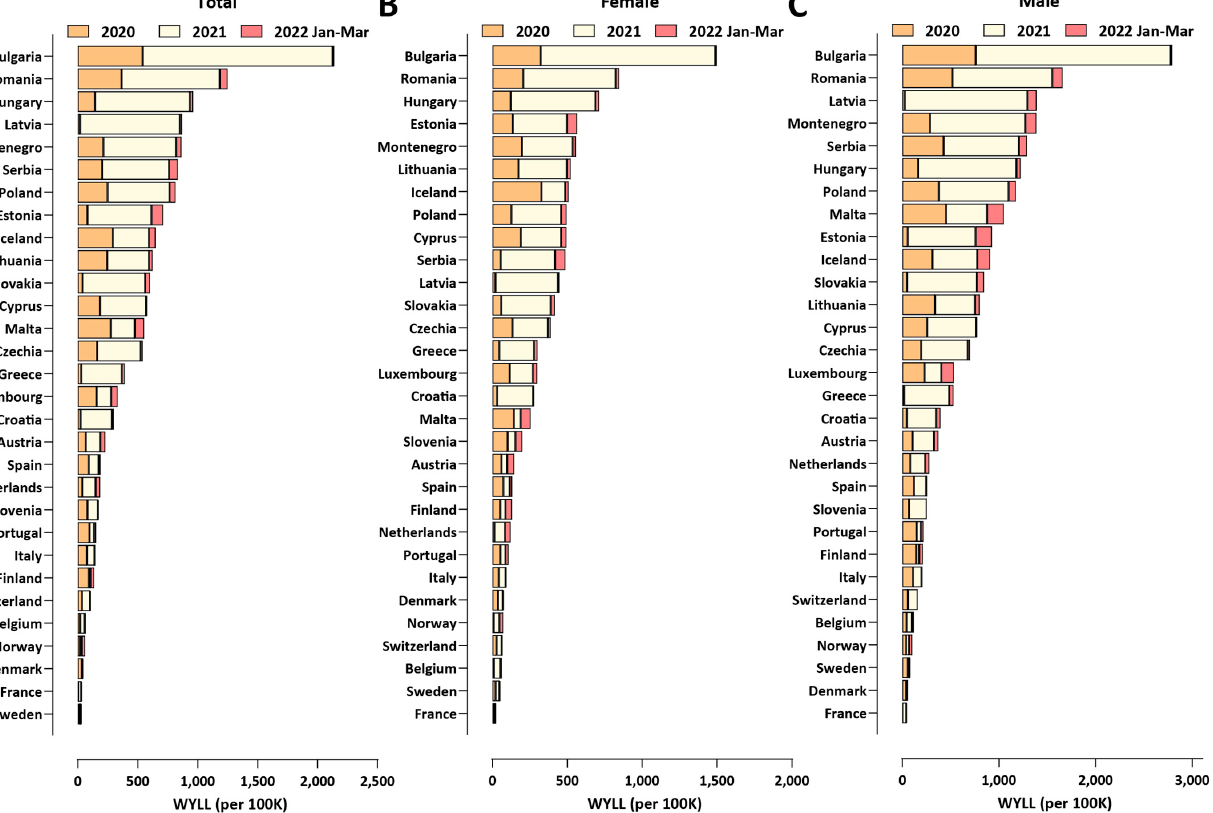
Figure 8. Working-age excess mortality in European countries during the COVID-19 pandemic (up to the end of March 2022). ( A ) Standardized WYLL values, in total; ( B ) standardized WYLL values, for females; ( C ) standardized WYLL values, for males.